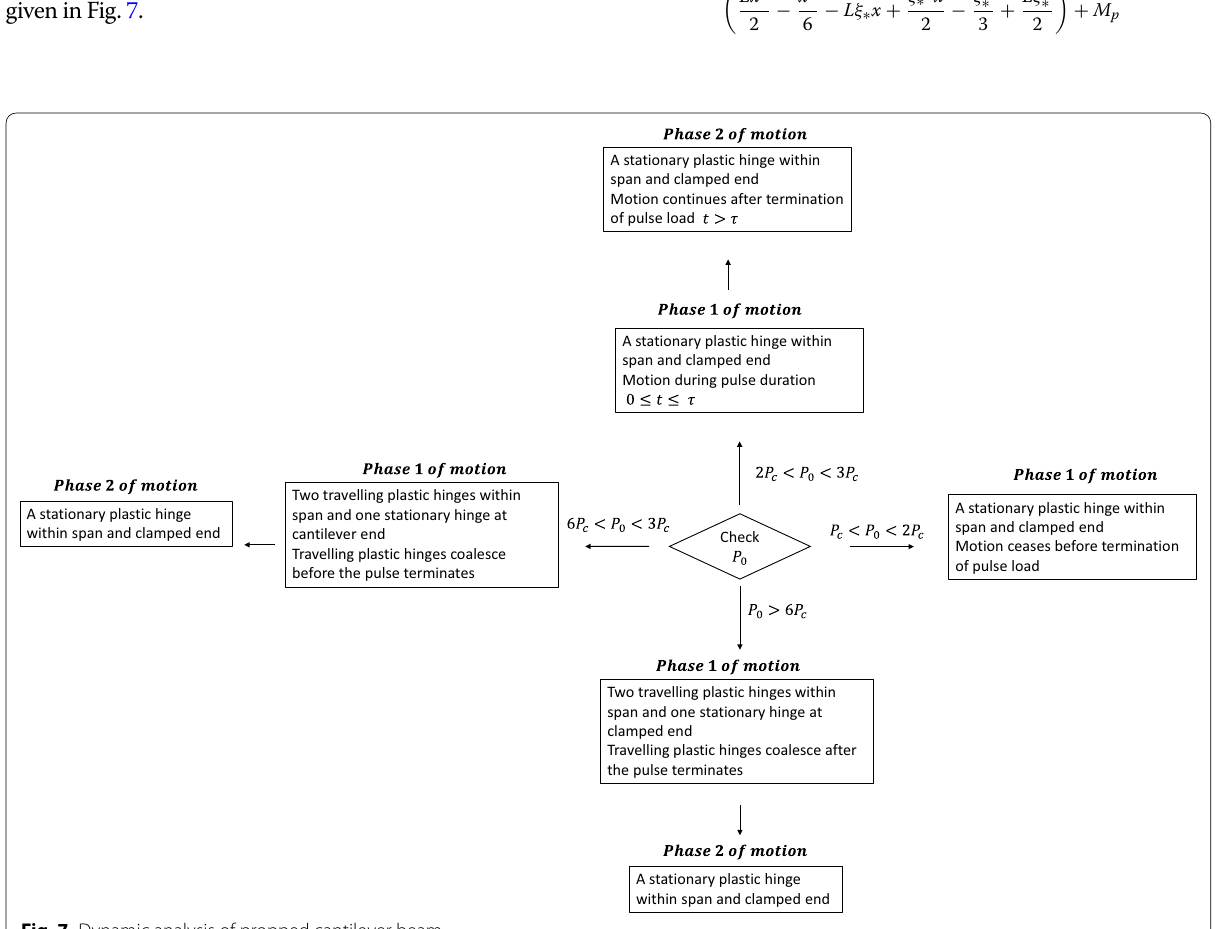
Fig. 7 Dynamic analysis of propped cantilever